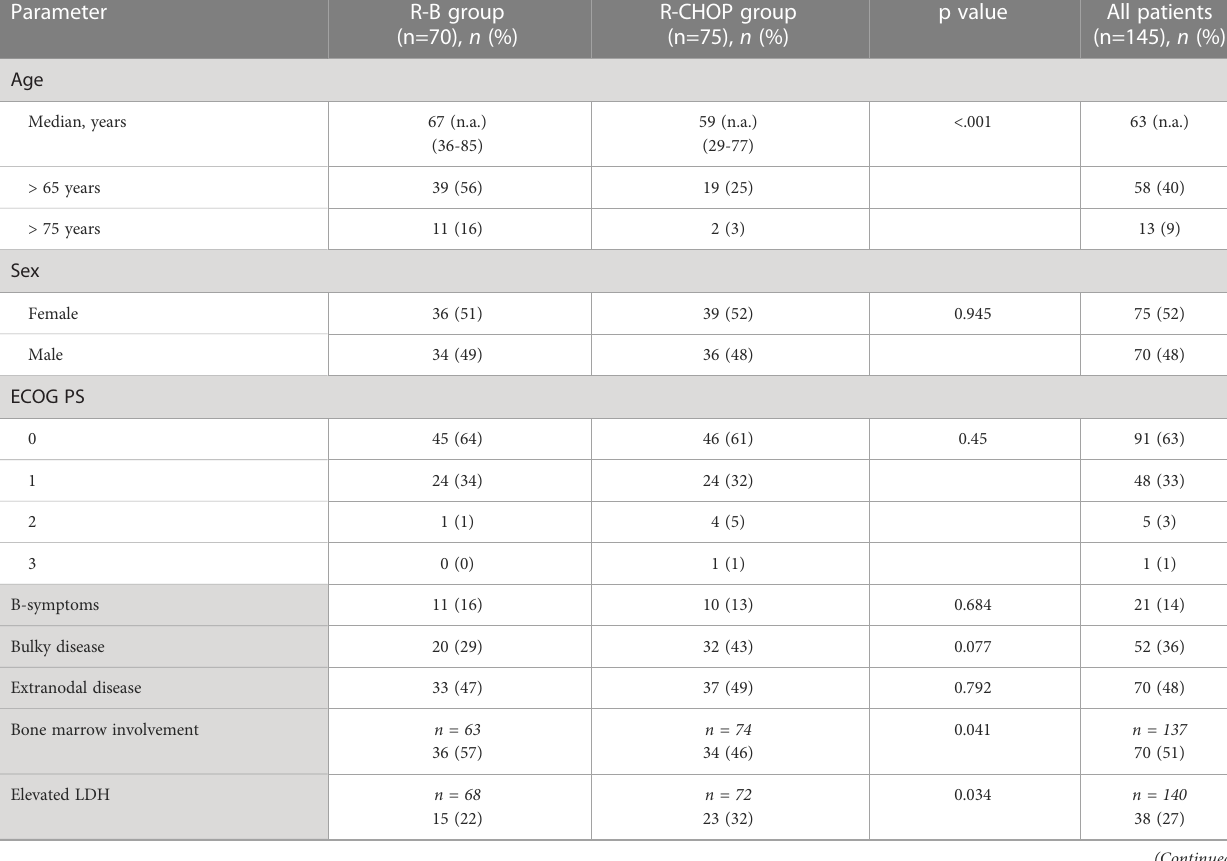
TABLE 1 Patient